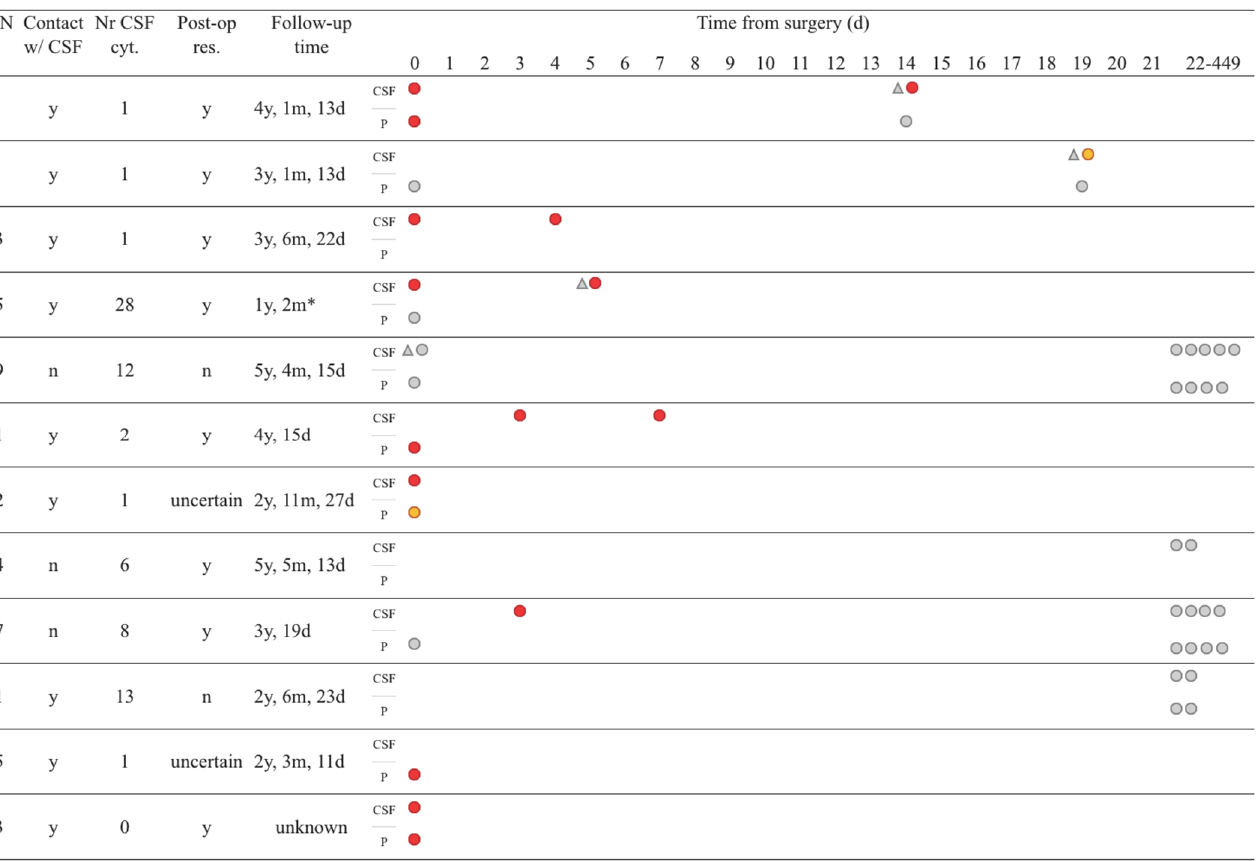
Figure 1. Liquid biopsy and CSF cytology results from surgery until three weeks post-operatively. Tumor location in relation to CSF reservoir as denoted on diagnostic MRI (contact with CSF; yes/no). Residual tumor tissue as denoted on post-operative MRI (post-op res; yes/no). Follow-up time based on the date of last MRI (y, year; m, month; d, day, asterisk denotes diseased). CSF, cerebrospinal fluid; P, plasma. CSF cytology (triangles) and ctDNA results (circles). ctDNA positive samples in red, trace positive samples in orange, and negative samples in grey.